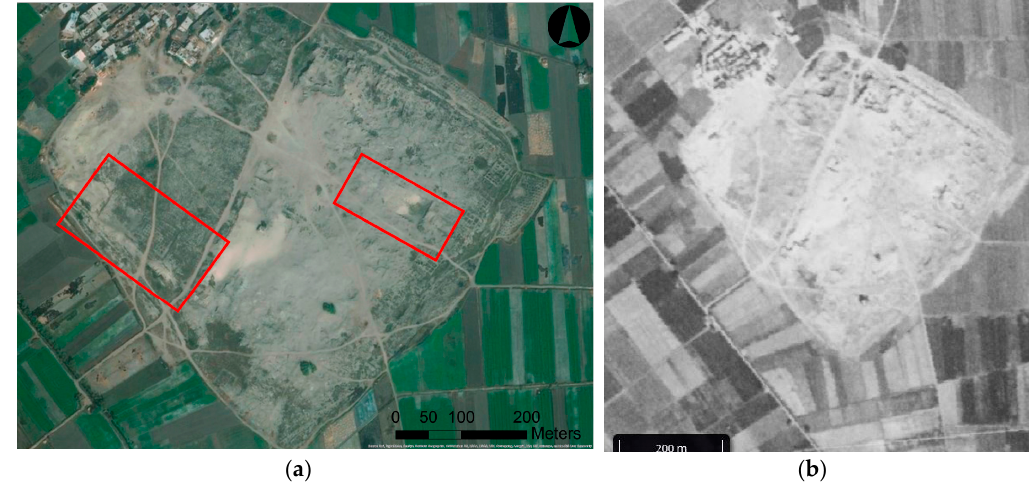
Figure 23. ( a ) The site of Tukh el Qaramus, with the temple of Philip Arrhideus in the western rectangle, and a potential temple in the eastern rectangle. Image courtesy Google Earth; ( b ) 1968 CORONA image. Image courtesy of the Center for Advanced Spatial Technologies, University of Arkansas/U.S. Geological Survey.